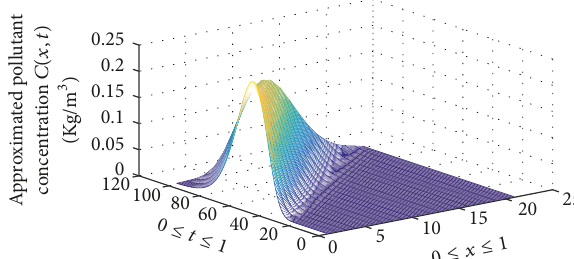
Figure 4: Comparison of analytical and approximated pollutant concentrations 𝑐(0.5, 𝑡) (kg/m 3 ) (Δ𝑥 = 0.0250 , Δ𝑡 = 0.0100 , Pe = 2.5) . Table 2: The maximum error of interpolated boundary condition functions to the analytical solution (see (16)). 𝐸(𝑇 𝑔 ) = max |𝑔(𝑡) −